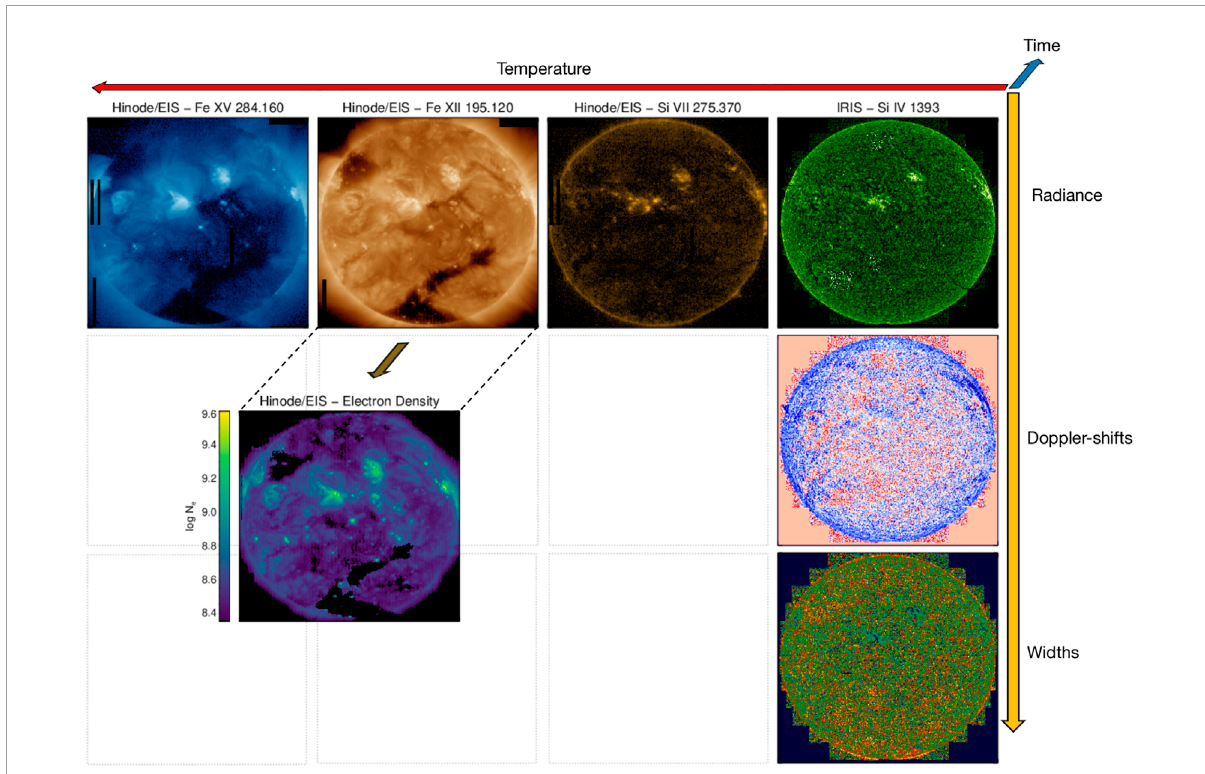
FIGURE 1 Representation of a sample of the multi-dimensional data products that a spatially resolved full-disk spectrograph would provide. The spectral dispersion would sample different spectral lines formed at different temperatures. Analysis of the spectral profiles would return radiance, Doppler velocities and spectral widths. The electron density and element composition would be computed from the ratios of the radiance of selected lines. Finally, consecutive spectra would establish the temporal variability. These images have been generated with Hinode/EIS wide slit (40 ′′ ) and IRIS (2 ′′ )